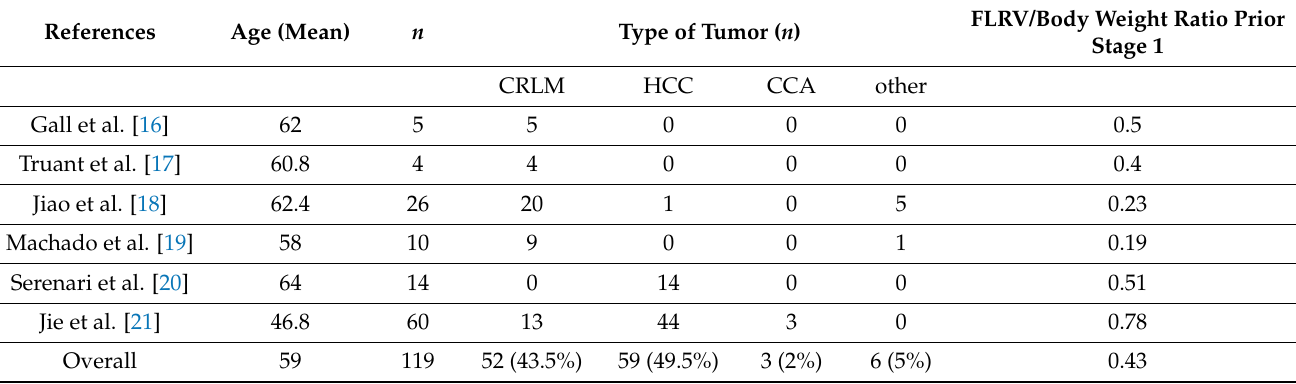
Table 1. Patients features.